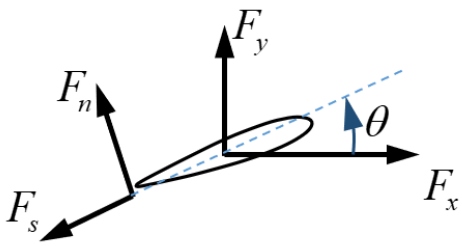
Figure 23. Phase diagrams of F y − V y and M z − ω z at nine working points.